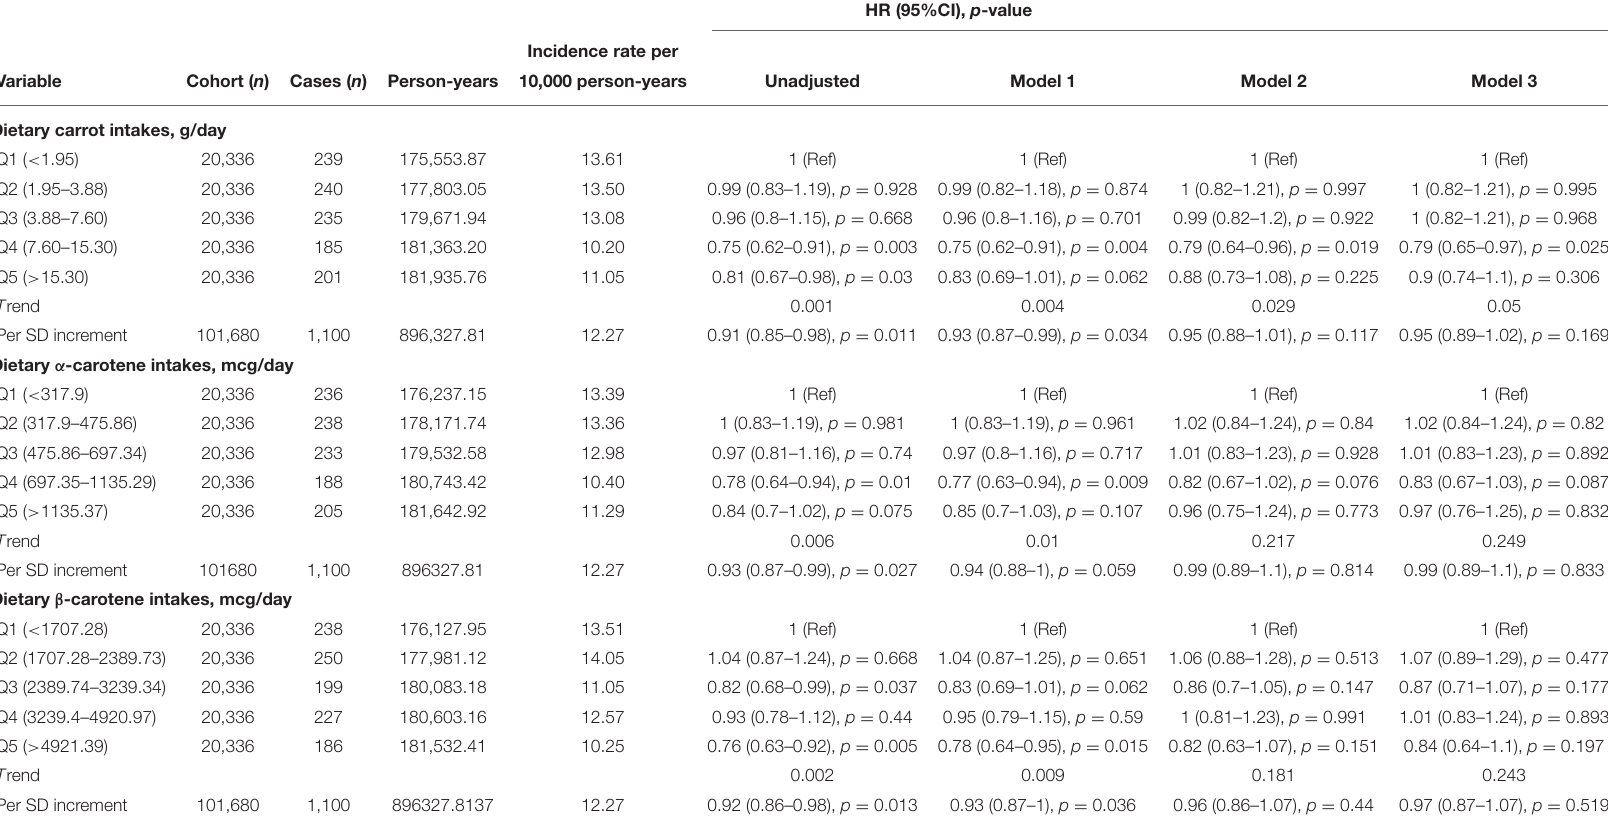
TABLE 2 | Association between energy-adjusted dietary carrot/carotene intakes and colorectal cancer incidence risk in the PLCO cancer screening trial.